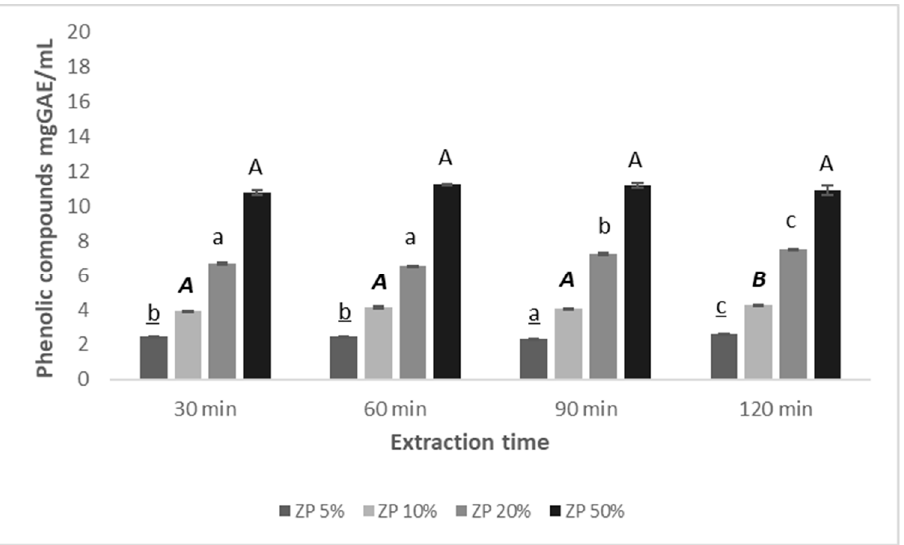
Figure 3. Efficiency in the extraction of phenolic compounds of Z. punctata aerial parts by using 5, 10, 20 and 50% plant material in 5% ethanol with different contact time (30, 60, 90 and 120 min). Different letters between bars for the same value of dry weight of Z. punctata indicate significant differences between phenolic compounds content at different time, according to Tukey’s test ( p ≤ 0.05). Capital letter (A,B), lowercase letter (a,b,c), capital and italic letter ( A , B ), lowercase and underlined (a,b,c) are used to Zp 50% Zp 20%, Zp 10% and Zp 5%, respectively.